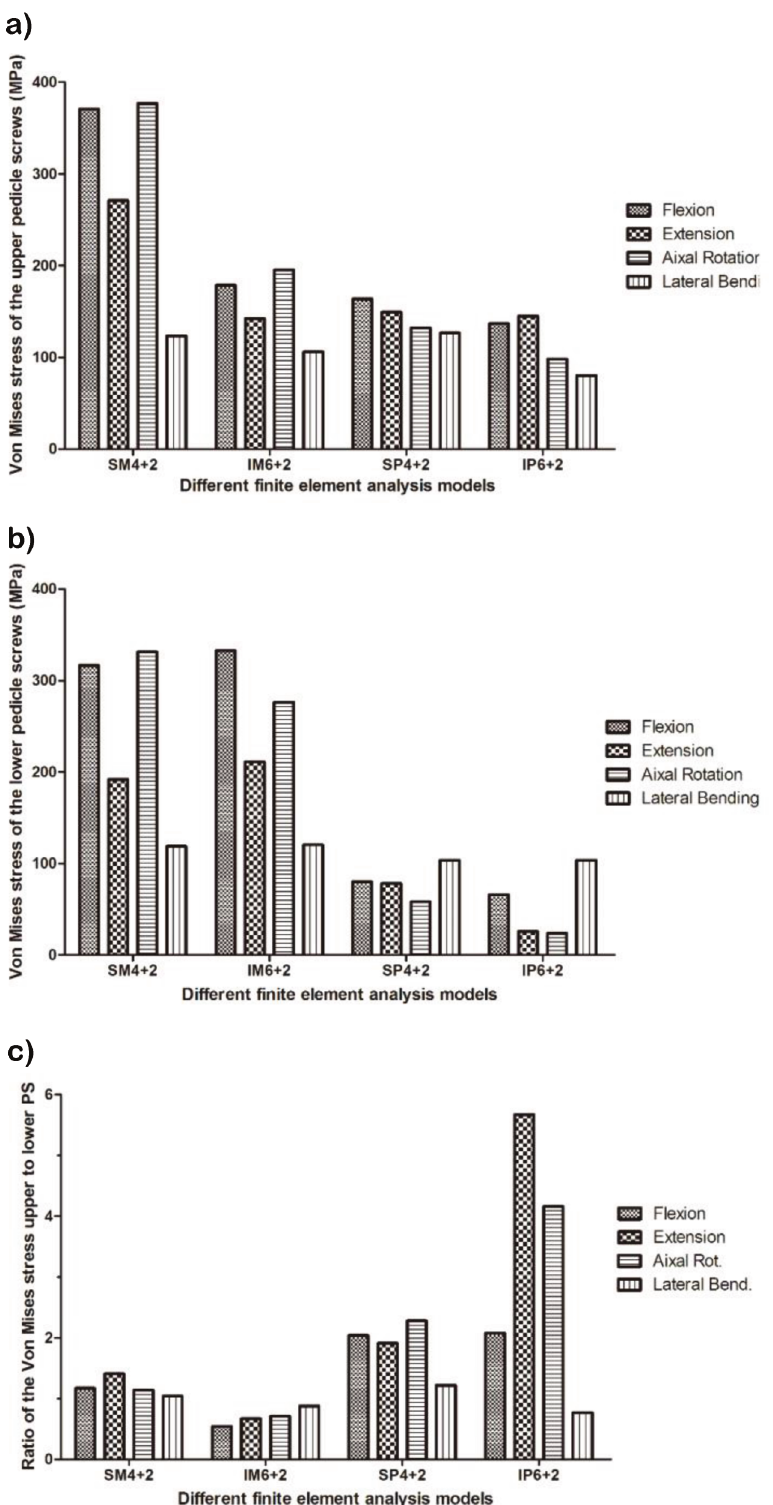
Figure 2 - von Mises stress of the pedicle screws. A. Upper pedicle screws. B. Lower pedicle screws. C. Ratio of von Mises stress of the upper to the lower pedicle screws. SM4 + 2/SP4 + 2 : short-segment monoaxial/polyaxial pedicle screw fixation; IM6 + 2/IP6 + 2 : intermediate monoaxial/polyaxial pedicle screw